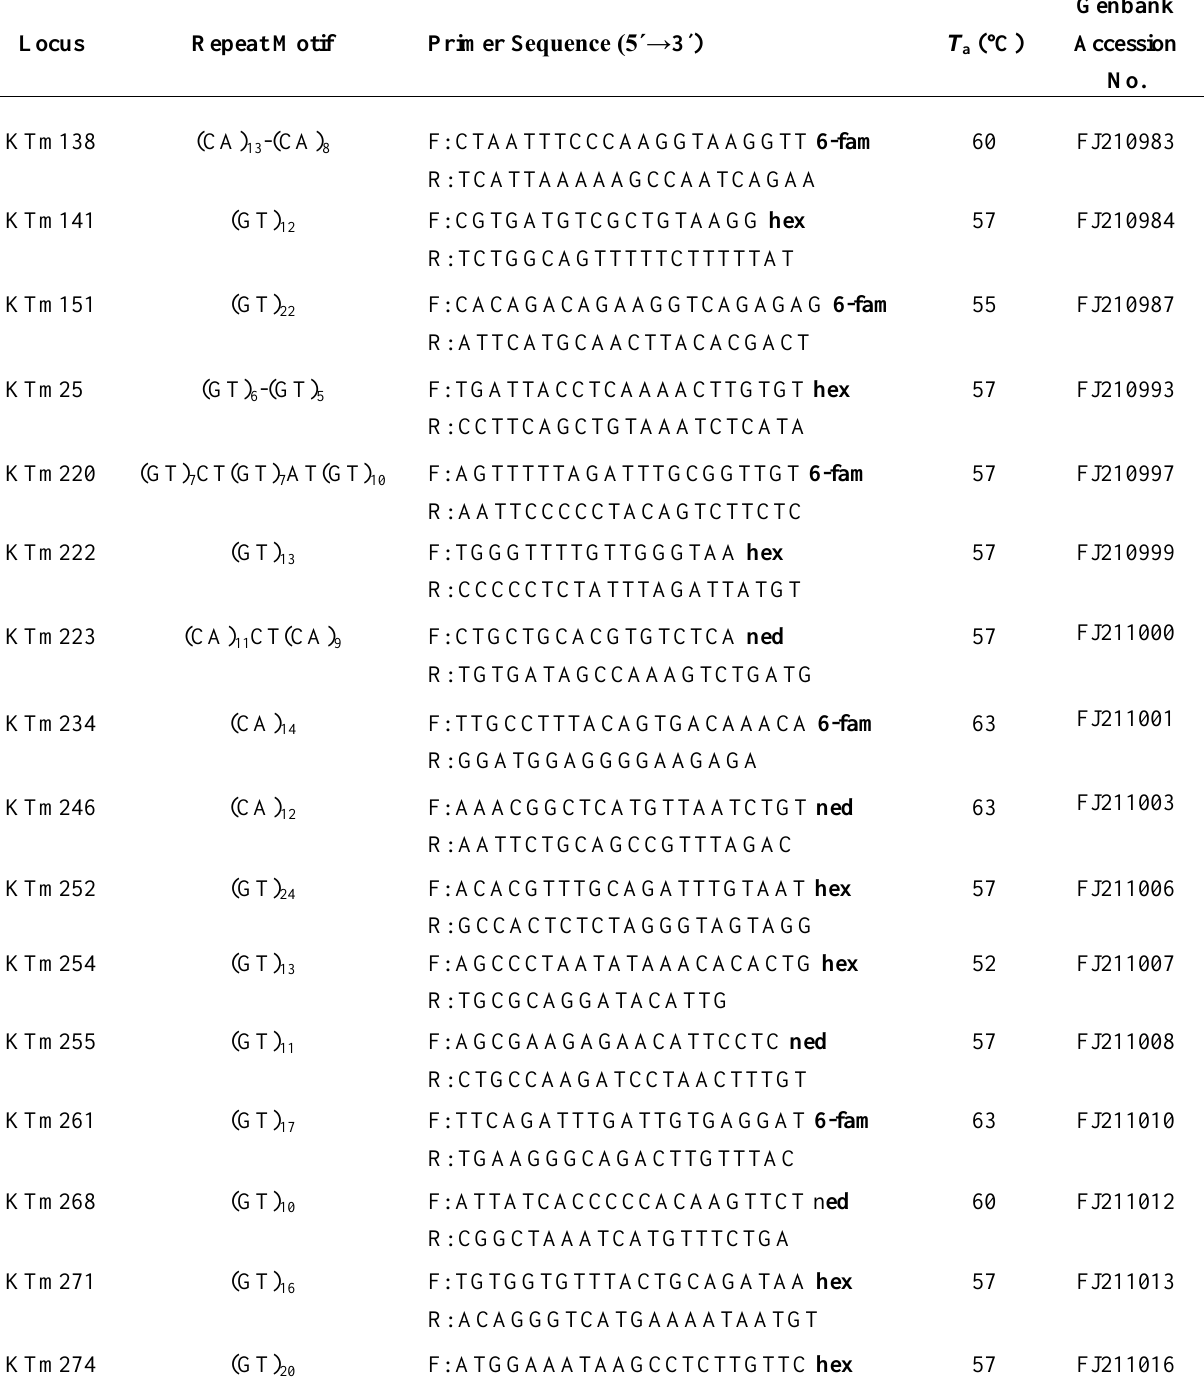
Table 1. Characteristics of the 20 microsatellite loci isolated from Thamnaconus modestus